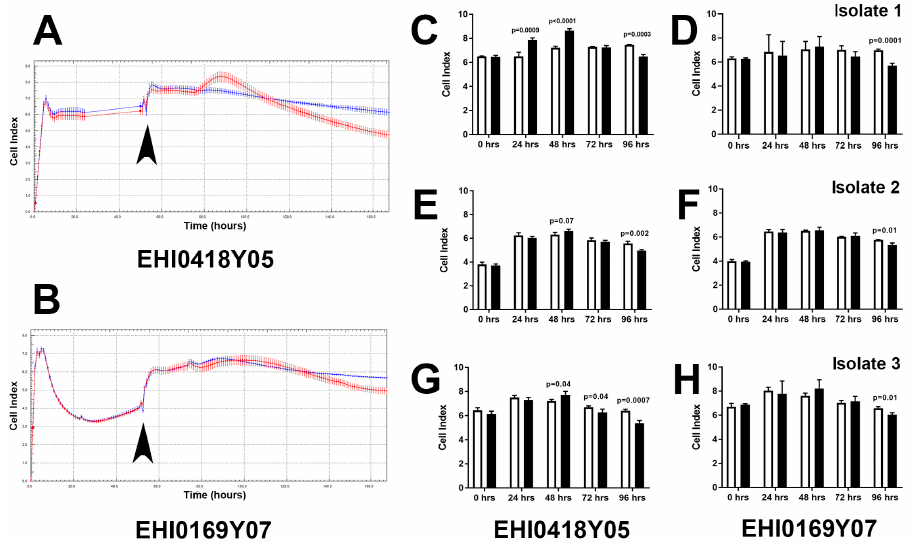
Figure 4. Effect of DENV-1 infection on barrier function of primary human retinal pigment epithe- lial cells: viral strains = Singapore National Environmental Agency Isolate (EHI)0418Y05 (isolated during 2005 epidemic) and EHI0169Y07 (isolated during 2007 epidemic); n = 3 primary human retinal pigment epithelial cell isolates, studied and presented separately; multiplicity of infection = 10; inoculation interval = 90 min; time of infection = 4 days. ( A , B ) Representative plots of transcellular electrical resistance across ( A ) EHI0418Y05-infected or ( B ) EHI0169Y07-infected (red) versus unin- fected (blue) cell monolayers, measured as cell index each hour. Arrowheads mark time of return to measurements following inoculation. Dots represent mean, with error bars indicating standard deviation; n = 3–4 monolayers per condition. ( C – H ) Graphs showing cell index at specified time intervals following inoculation for ( C , E , G ) EHI0418Y05-infected or ( D , F , H ) EHI0169Y07-infected (black) versus uninfected (white) cell monolayers for three individual primary cell isolates. Bars represent mean, with error bars showing standard deviation; n = 3–4 monolayers per condition. Data were analyzed by 2-tailed Student’s t